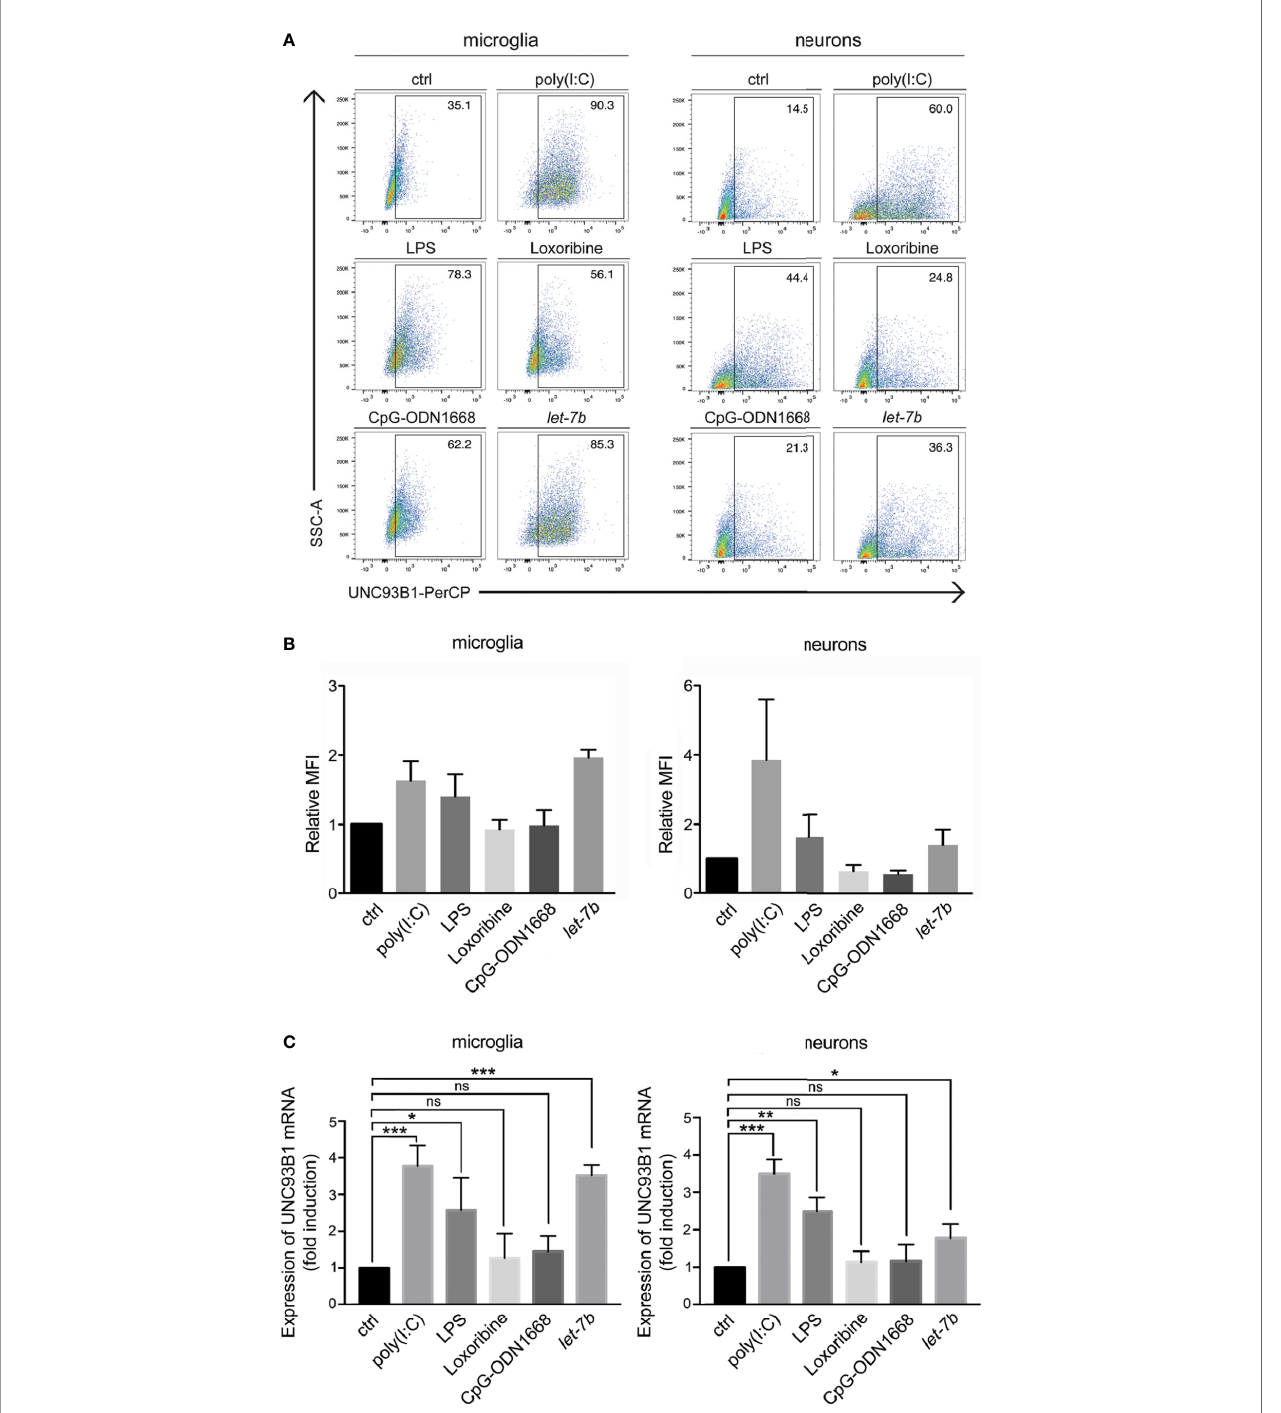
FIGURE 3 | UNC93B1 expression in microglia and neurons is regulated by TLR activation. (A) Microglia and neurons isolated from C57BL/6 mice, were exposed to poly(I:C) (150 µg/ml), LPS (1 µg/ml), loxoribine (1 mM), CpG-ODN 1668 (50 µM), or let-7b oligoribonucleotide (20 µg/ml) for 6 h Subsequently, cells were dissociated, labeled with both anti-UNC93B1-N and the respective antibodies for cell-speci fi c markers, and were analyzed by fl ow cytometry. (B) Results were expressed as fold change of UNC93B1 PerCP median fl uorescence intensity of CD11b + (microglia) and betaIII-tubulin + (neurons) cells (relative MFI; TLR agonist treatment vs. control, ctrl; n = 3) and are presented as mean ± SEM. (C) qPCR analysis of the cell cultures treated as described above using primers against UNC93B1 was performed. b -actin served as loading control. Relative Unc93b1 mRNA expression levels (TLR agonist treatment vs. control, ctrl) are shown ( n = 3). Results are presented as mean ± SEM. P values for relevant groups were determined by Student ’ s t test. p * < 0.05; ** p < 0.01; *** p < 0.001; ns, not signi fi